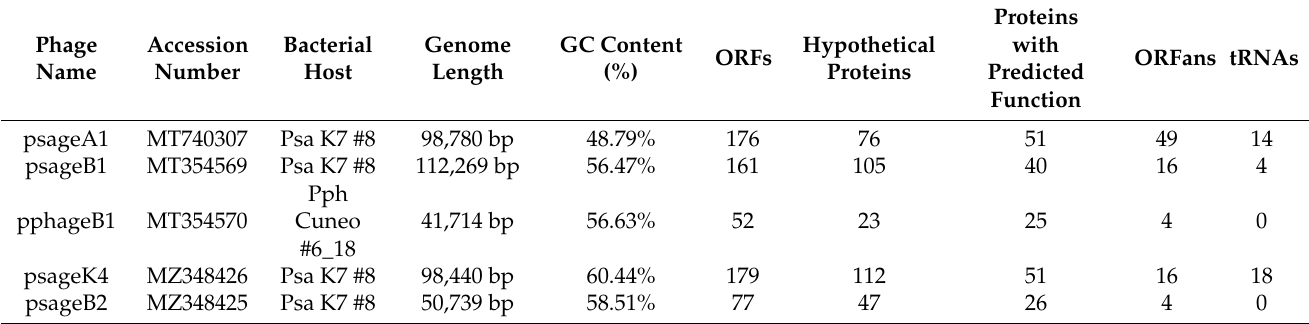
Table 3. Summary of the characteristic of the genomes of selected